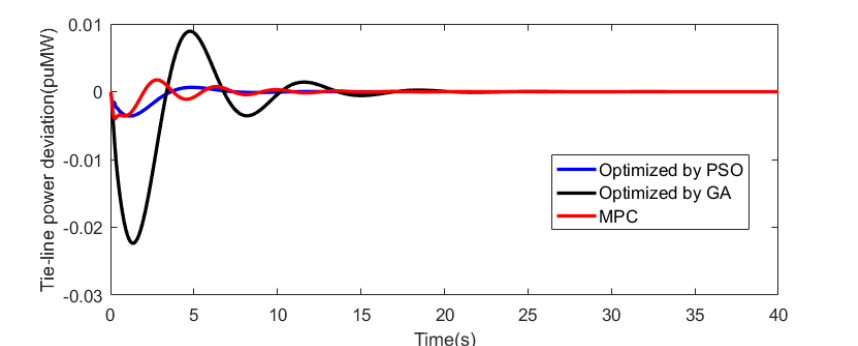
Figure 9. Tie-line power deviation for the first case.